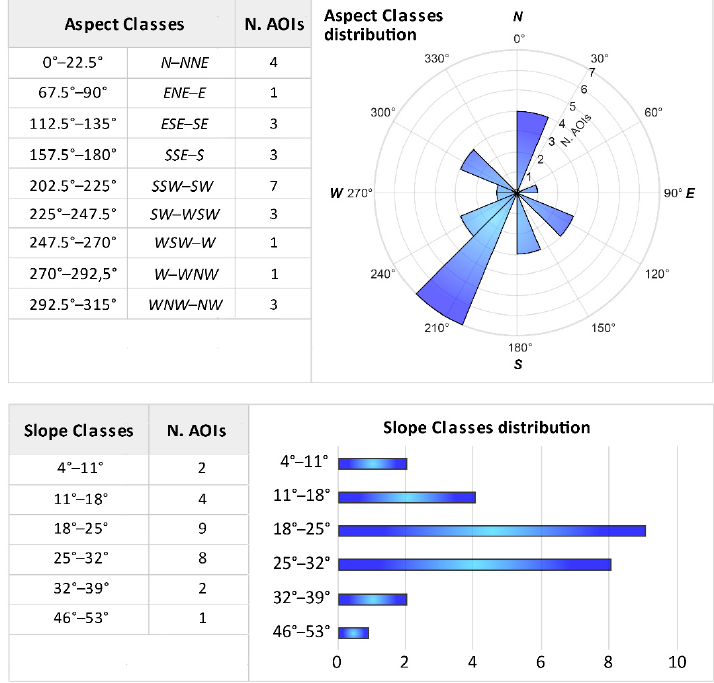
Figure 9. Aspect and Slope Classes for the investigated AOIs. Both Aspect and Slope have been represented through classes with a constant sampling interval of 22.5 ◦ and 7 ◦